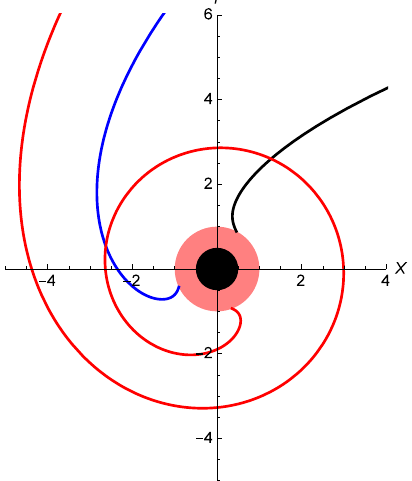
Figure 8. Numerical simulation of the scenarios where the traveling body approaches the black hole (rotating in the opposite direction) and becomes entrapped by the “whirlpool” of space–time. The impact of the curved space–time (the Kerr metric) in the vicinity of the black hole remarkably resembles a gigantic whirlpool (Figure 9). 9